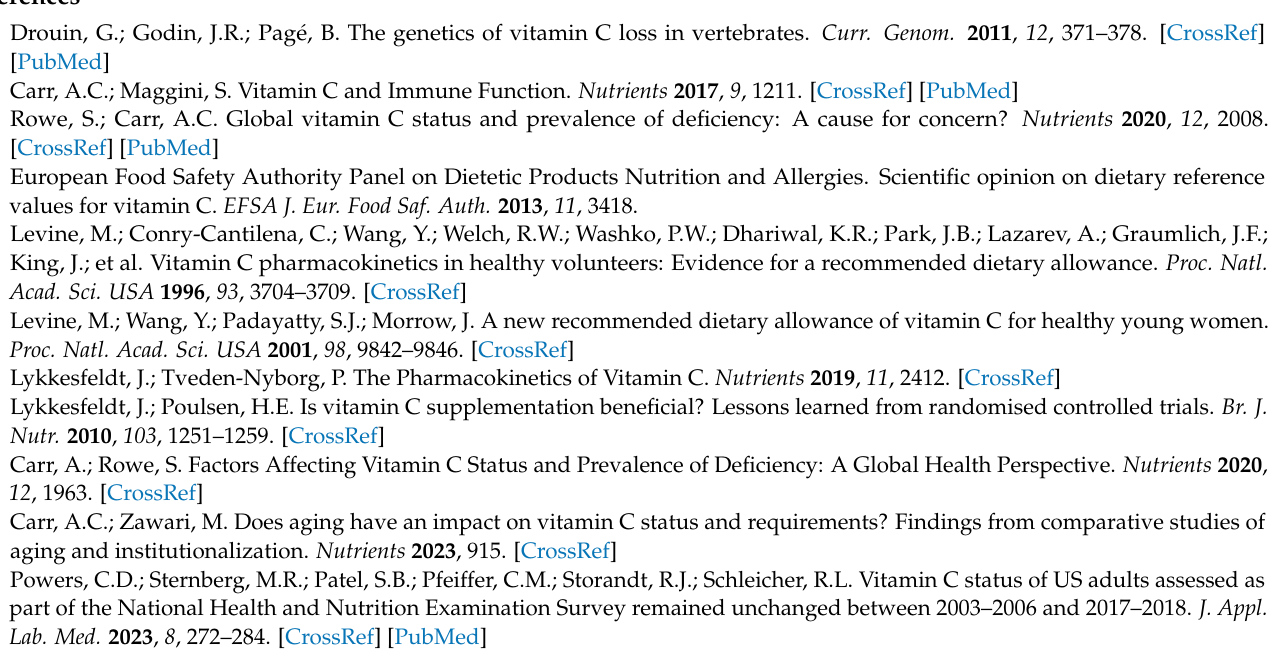
relative to smoking status stratified by gender; Figure S2. Vitamin C dose-response relationship relative to body weight; Figure S3. Vitamin C dose-response relationship relative to body weight stratified by gender; Figure S4. Vitamin C dose-response relationship relative to BMI; Figure S5. Vitamin C dose-response relationship relative to BMI stratified by gender; Figure S6. Vitamin C dose-response relationship relative to age; Figure S7. Vitamin C dose-response relationship relative to ethnicity; Figure S8. Vitamin C dose-response relationship relative to socioeconomic status; Table S1. Summary of intake and concentration estimates from dose-concentration